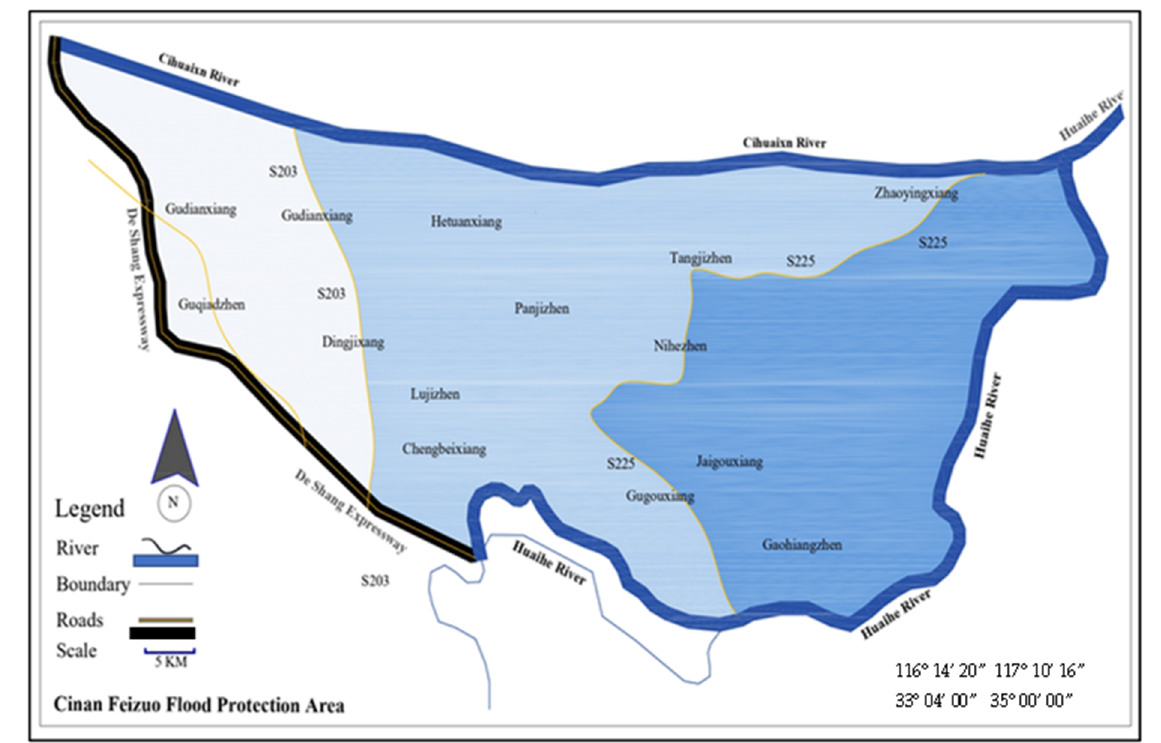
Figure 1. Huaihe River and Cinan Fiezuo flood protection area: topographic elevation, drainage water boundaries ( upper ), and Cinan Feizuo flood protection area with side artificial Cihuaixn channel and Huaihe River ( lower ).